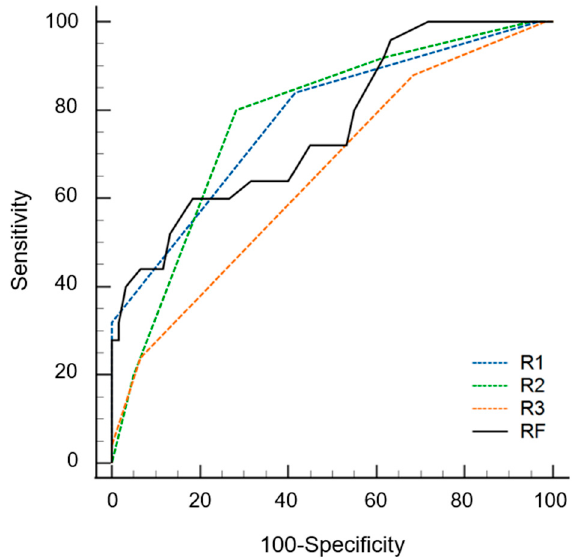
Figure 4. Receiver operating curves of radiomics model (RF) and three radiologists (R1, R2 and R3) for differentiating multiple myeloma from osteolytic metastasis. Table 4. Comparison of diagnostic performance of radiomics model and radiologists.